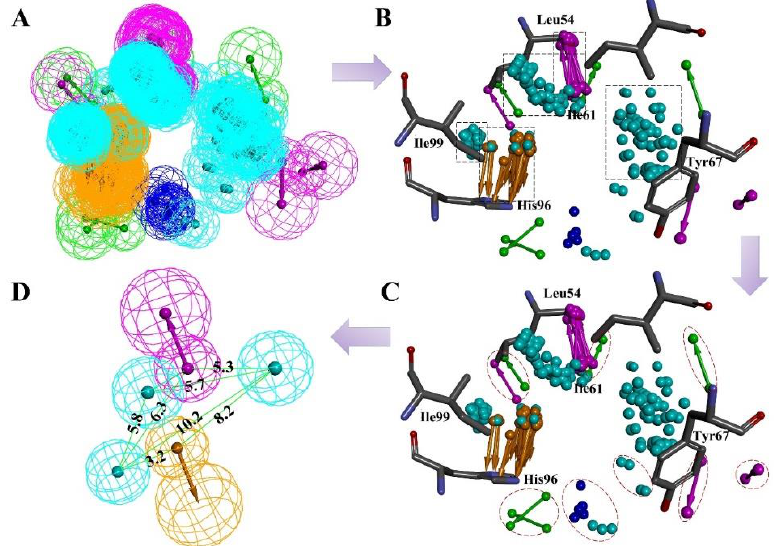
Figure 1. ( A ) The pharmacophore hypotheses were generated by LigandScout algorithm based on 64 MDM2/non-peptide complexes. ( B ) All 64 pharmacophore queries aligned to define the common features. ( C ) All common features were clustered to several parts. The features which unmatched the rule are highlighted by red dotted lines. ( D ) The key features were retained and merged to center features according to the clustering rule. Purple is a hydrogen bond donor; green is a hydrogen bond acceptor, and cyan is a hydrophobic or an aromatic element.